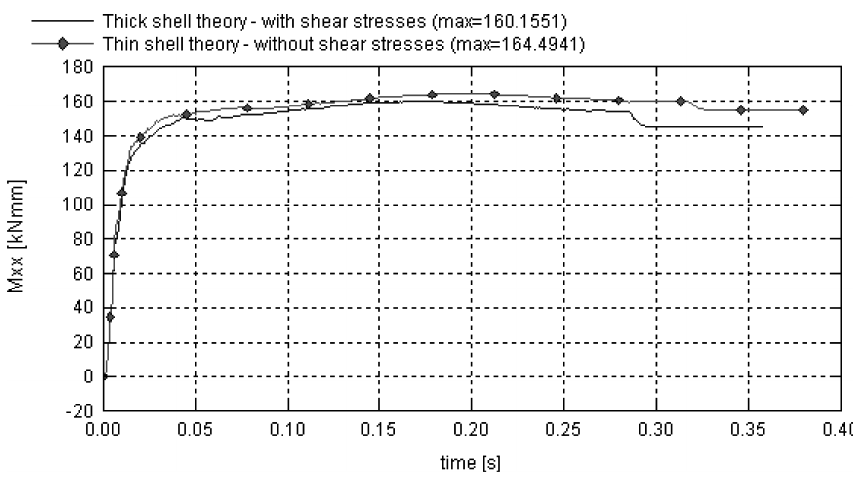
Fig. 16. Radial displacement for a cylinder subjected to a ring of pressure ( t = 5 mm ).